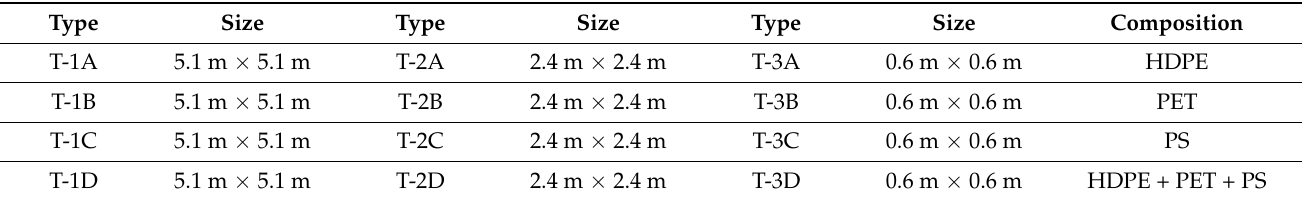
Figure 2. Unmanned Aerial Vehicle (UAV) image of large-sized (T-1x, red circles), medium-sized (T-2x, green circles), and small-sized (T-3x, yellow circles) floating plastic targets at Tsamakia Beach (Mytilene) on 22 October 2020 (sensing date) as well as details of the plastic targets during the construction stage. Due to their small sizes, the four small floating plastic targets (T-3x) were not clearly visible. Table 1. Specifications of the 12 plastic targets: three targets were made using high-density polyethylene (HDPE); three targets were made using polyethylene terephthalate (PET); three other targets were made using polystyrene (PS), and the last three targets were realised with all the above materials over an equal surface area [17].